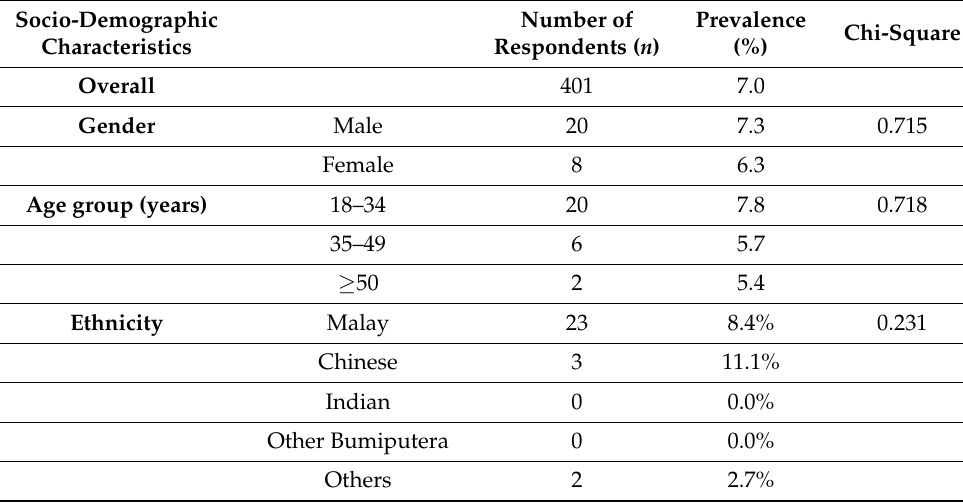
Table 2. Prevalence of anxiety by socio-demographic characteristics ( n =